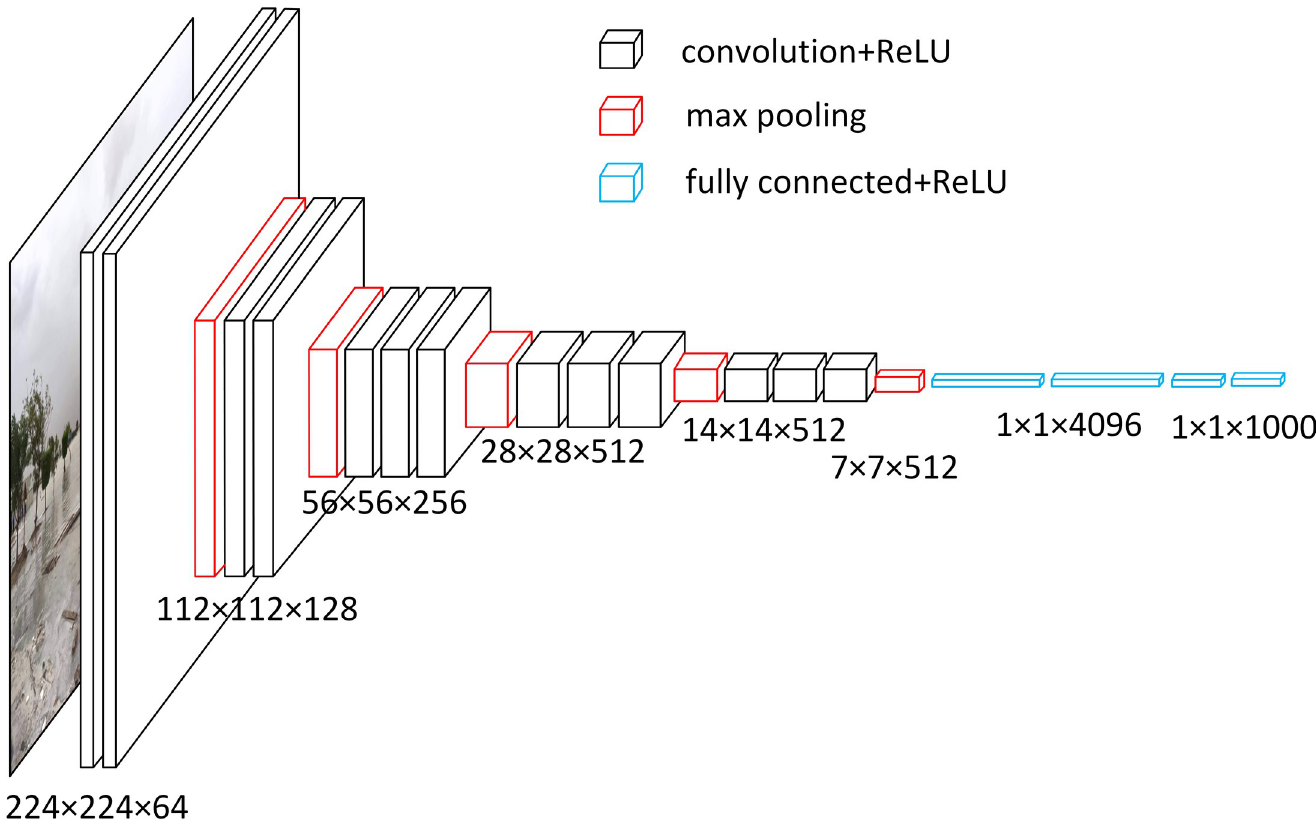
Fig 3. VGG-16 architecture for converting images into flattened